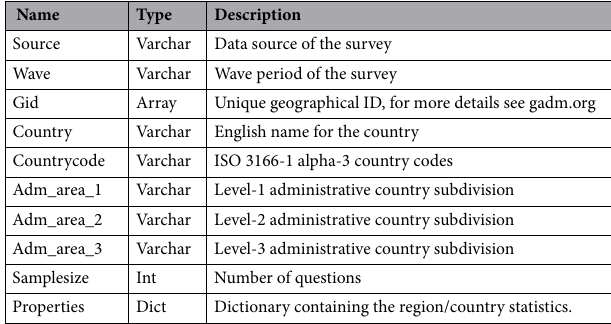
Table 6. Schema for SURVEYS table.